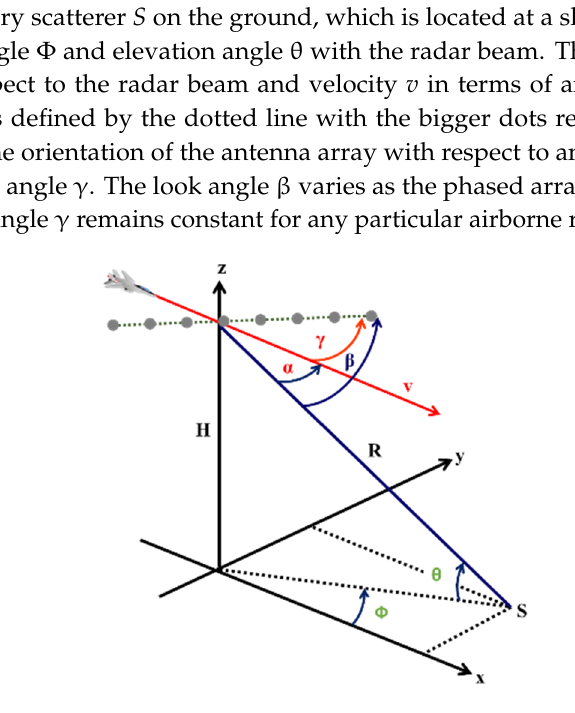
Figure 3. Geometry of the forward-looking airborne radar.